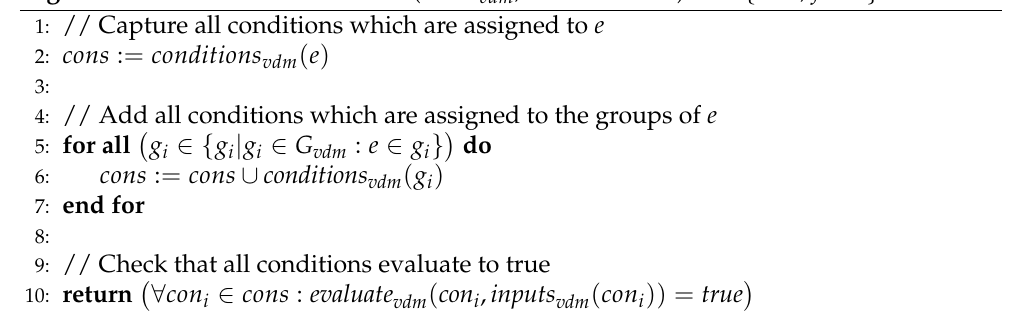
Algorithm 2 checkElementPresence( e ∈ E vdm , vdm ∈ VDM ): b ∈ { true , f alse